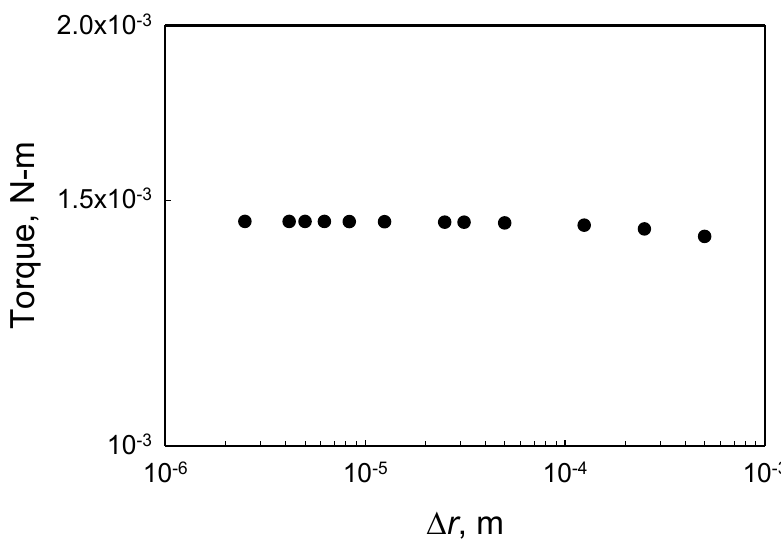
Figure A4. The effects of the radial distance increment Δ r on the torques calculated using numerical integration for the conditions of H = 0.001 m and Ω = 2 rad/s.